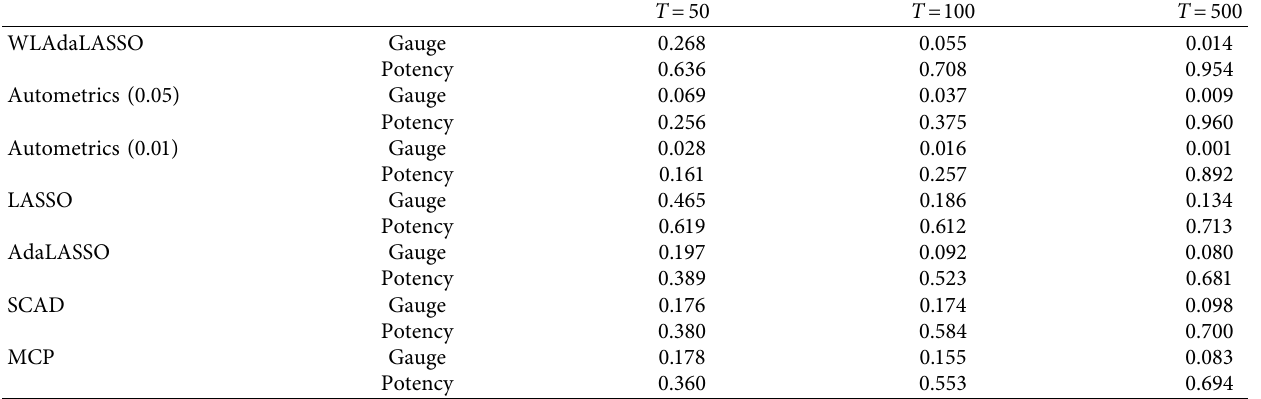
Table 1: Simulated result with ϕ equal to 0.1.